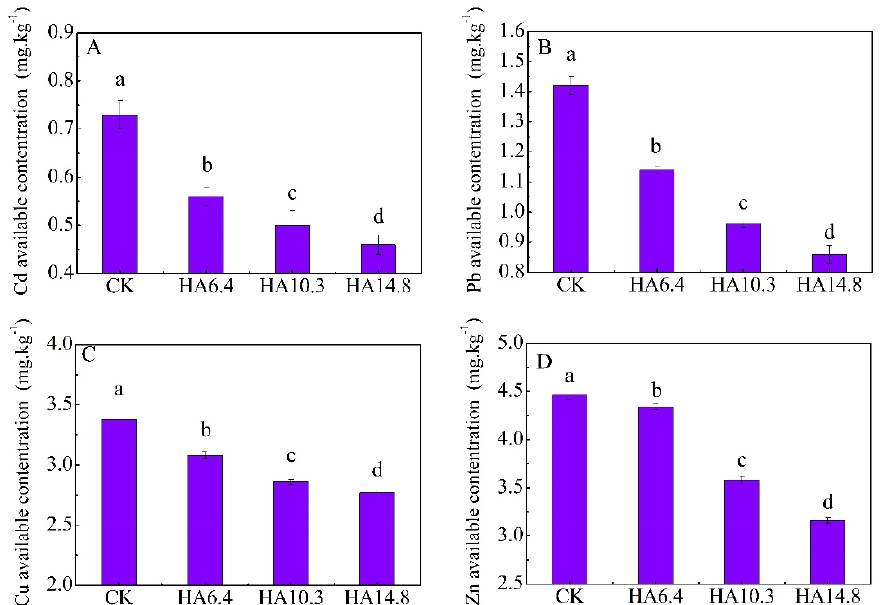
Figure 1. The DTPA-extracted Cd (A), Pb (B), Cu (C), and Zn (D) in soil after harvest of tobacco. Different lowercase letters in the same column indicate significant differences at p < 0.05 according to Duncan’s test. Bars represent standard errors ( n = 4).